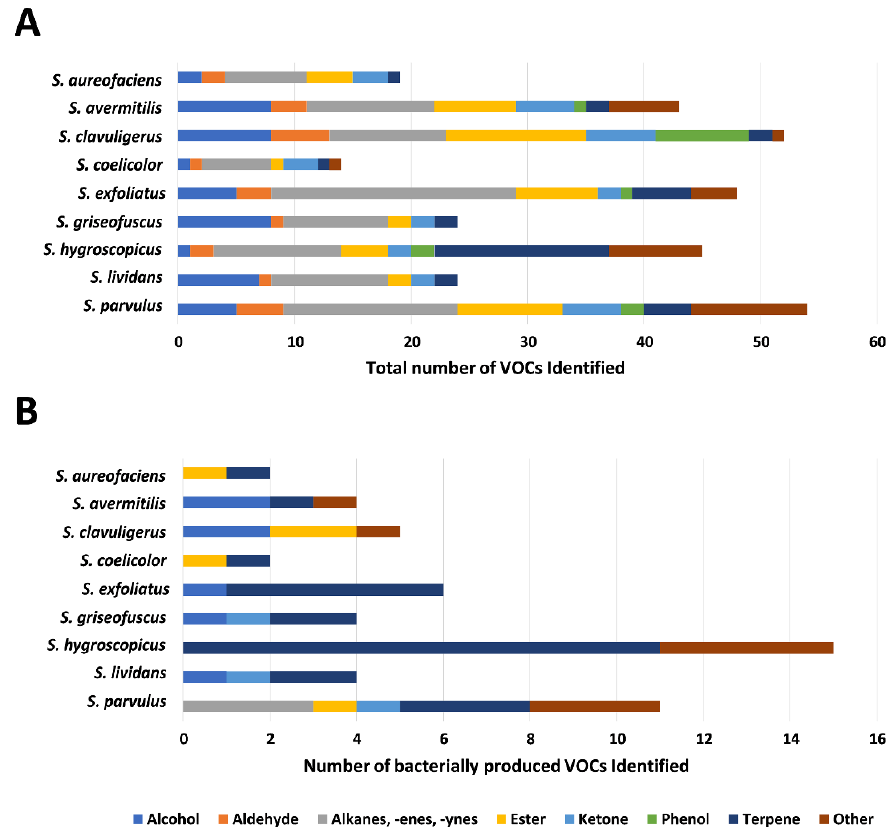
Figure 2. Identified volatile organic compounds (VOC) grouped according to functional classes. ( A ) Total identified VOCs attributed to bacterial origin and those derived from the media. ( B ) Identified VOCs of bacterial origin only.